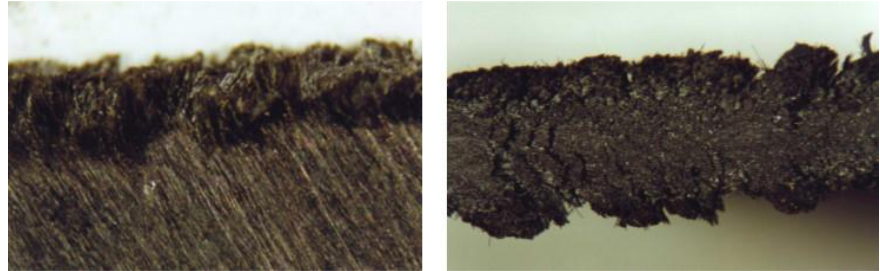
Figure 3. Damaged CFRP pultruded specimen trimmed with the V-shaped tool. Fibre orientation angle θ = 120° [62].